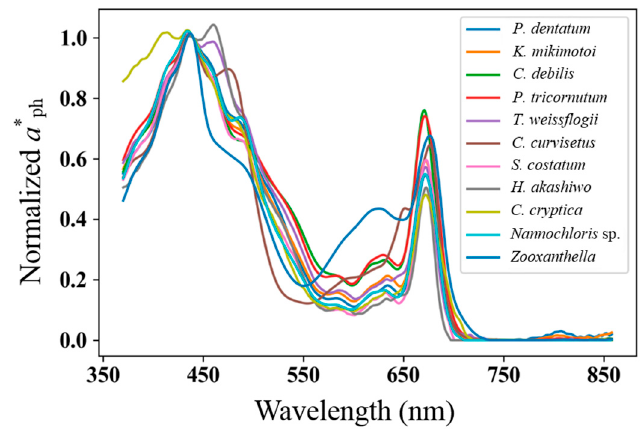
Figure 2. Representative mass-specific absorption spectra (normalized at 440 nm) of 11 species commonly observed in Chinese ocean regions.